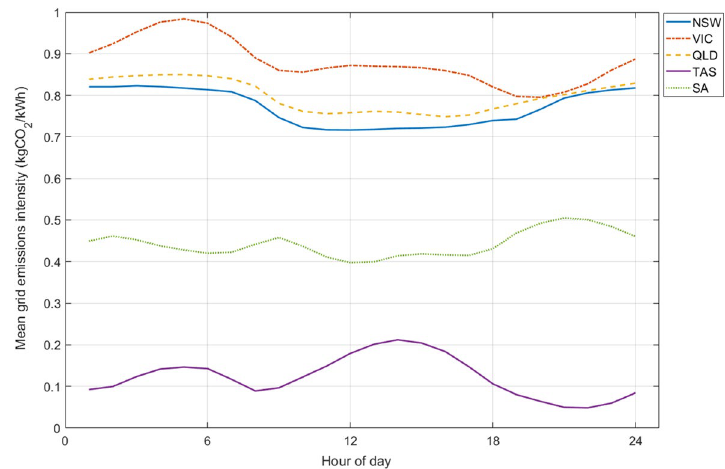
Fig. 5 Mean hourly variation of grid emission intensity for the five NEM